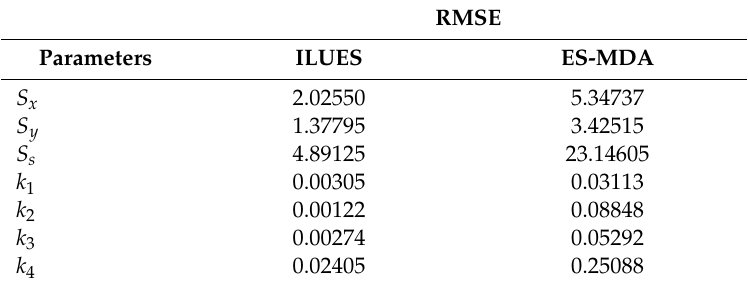
Figure 13. Box plots of model parameters estimated by ILUES in Case 3: ( a , b ) source location ( S x , S y ) , ( c ) source strength ( S s ) , ( d – g ) the four rate constants ( k 1 , k 2 , k 3 , k 4 ) . The red dashed lines denote the true values of corresponding model parameters. Table 7. The RMSE of selected model parameters estimated by ILUES and